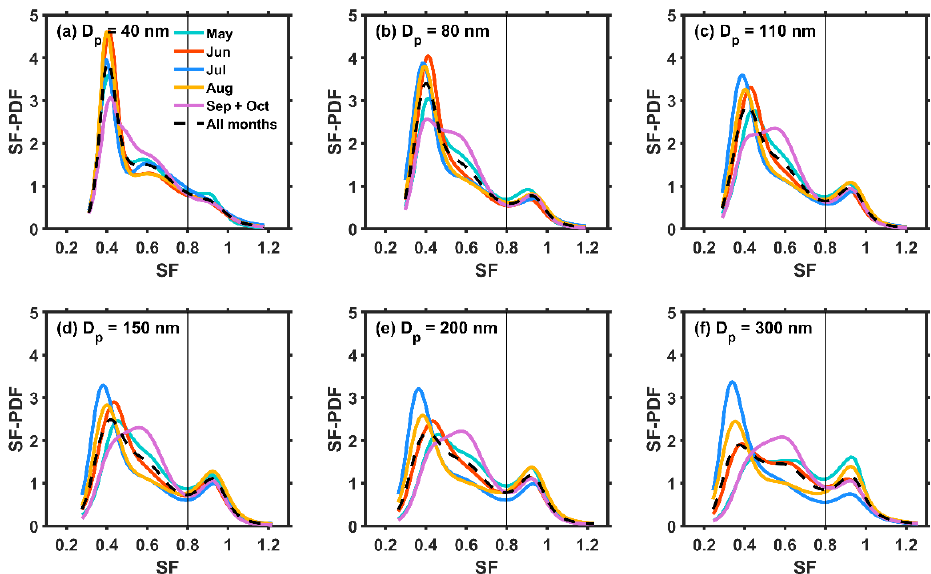
Figure 4. Monthly variations in the mean shrink factor (SF) probability distribution functions (SF-PDFs) for particles with diameters of (a) 40, (b) 80, (c) 110, (d) 150, (e) 200, and (f) 300nm.